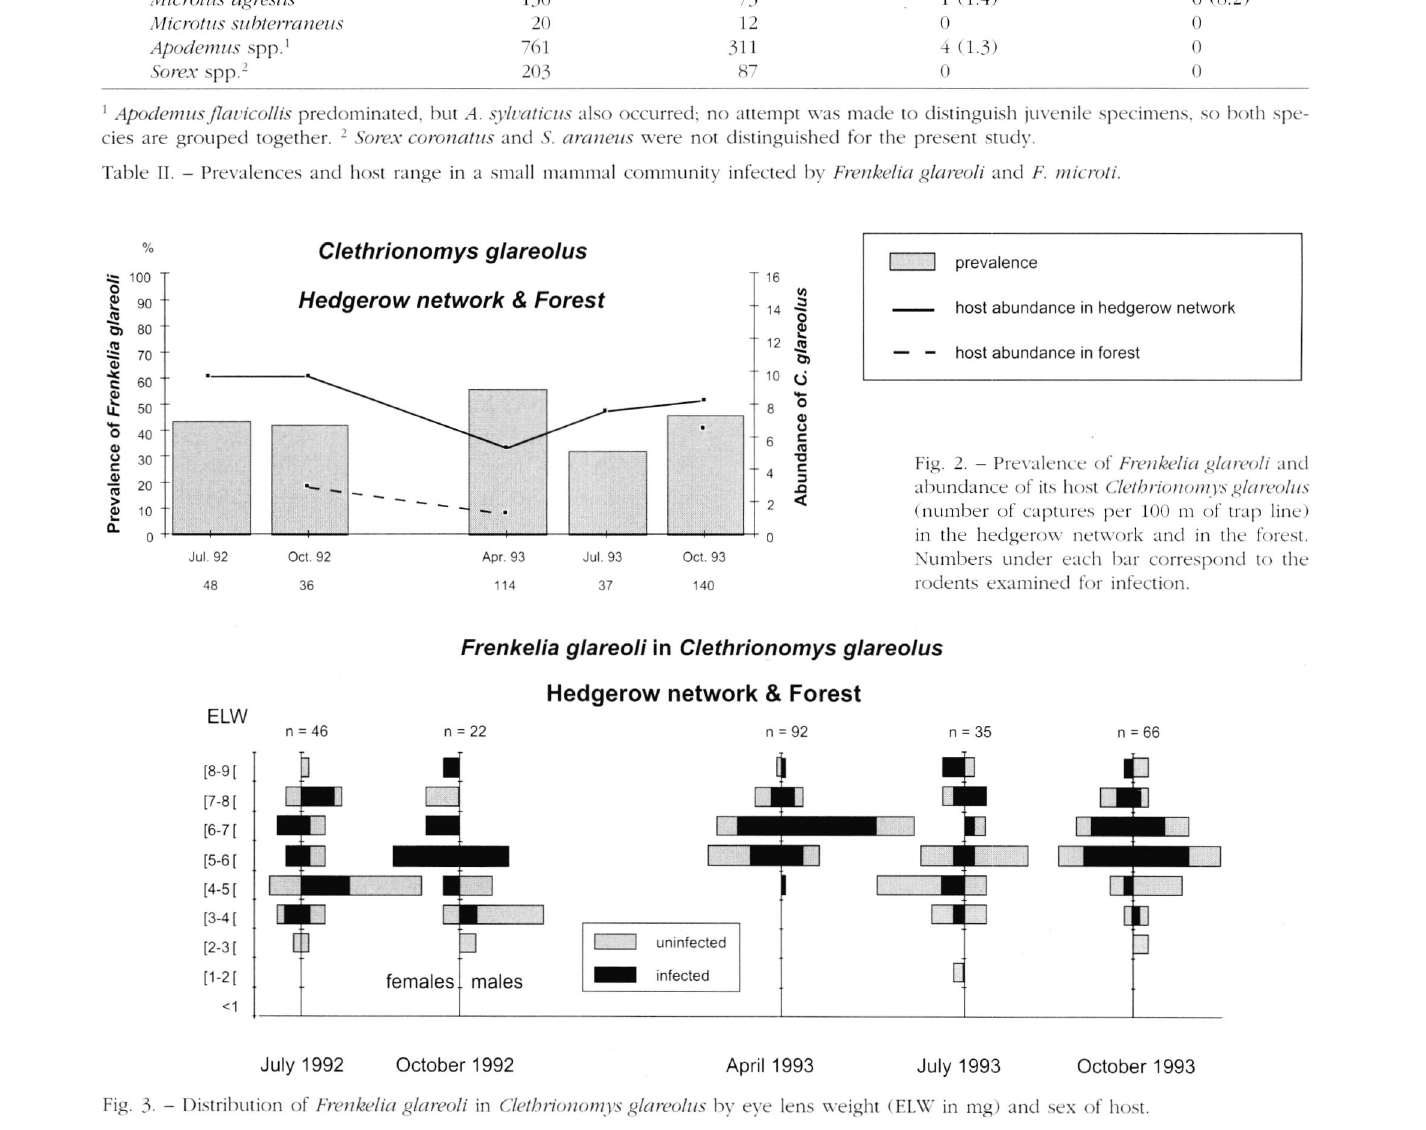
Fig. 3. - Distribution of Frenkelia glareoli in Clethrionomys glareolus by eye lens weight (F.LW in mg) and sex of